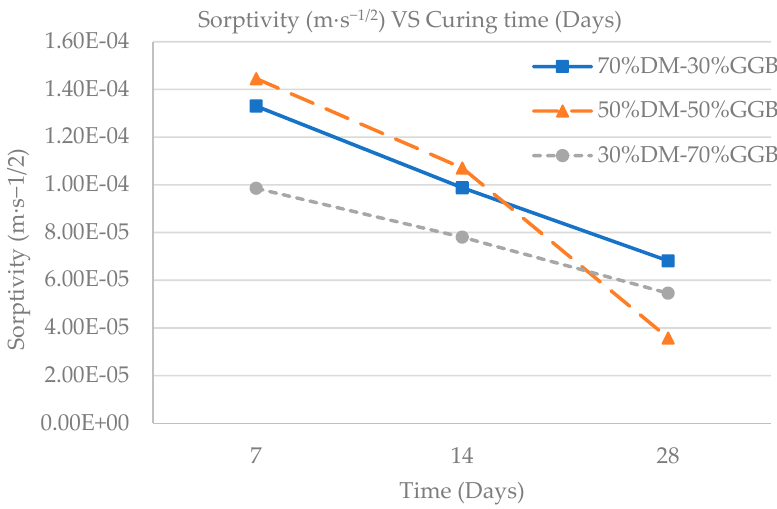
Figure 10. Sorptivity vs. Maturity per Geopolymer Mixture.